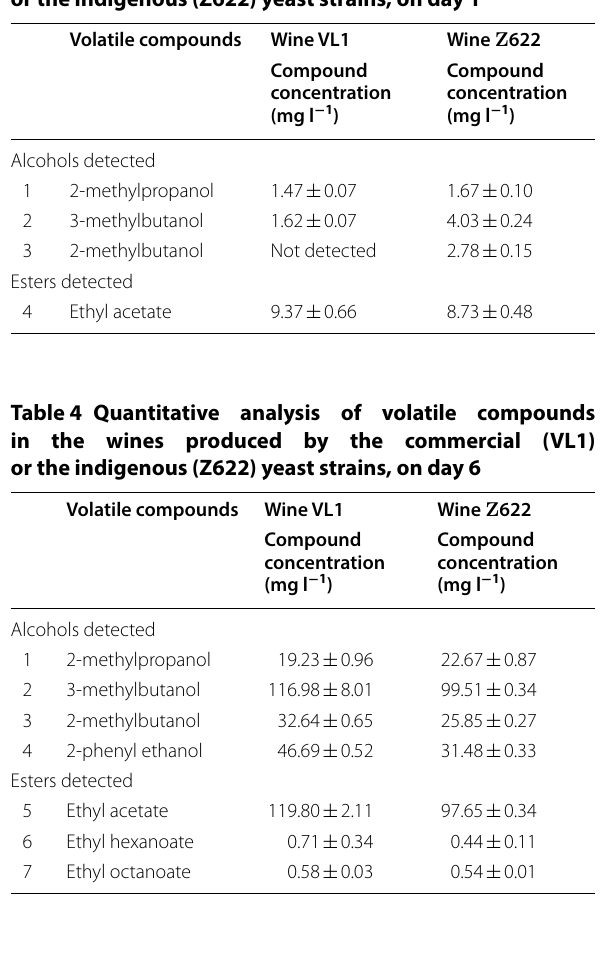
produce wines with high concentrations of fusel alcohols Table 3 Quantitative analysis of volatile compounds